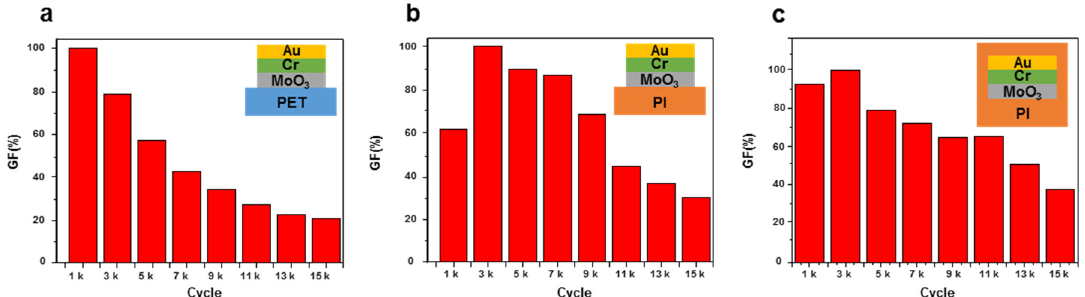
Figure 4. Marathon test of the crack sensors up to 15,000 cycles. ( a ) Durability test result of the crack sensor on PET substrate. ( b ) Durability test result of the crack sensor on PI substrate. ( c ) Durability test result of the PI encapsulated crack sensor on PI substrate.